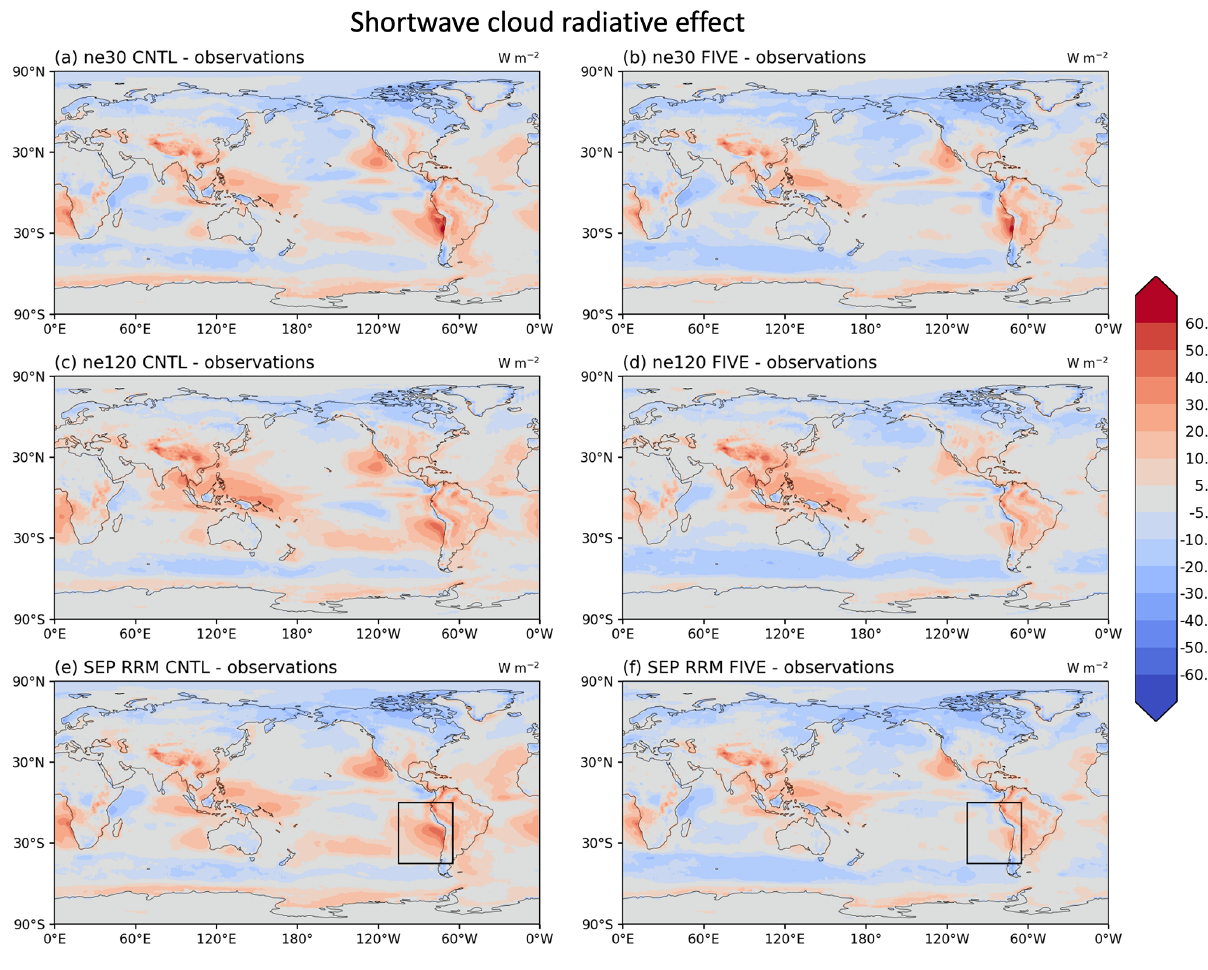
Figure 7. Same as Fig. 4 but for shortwave cloud radiative effect.